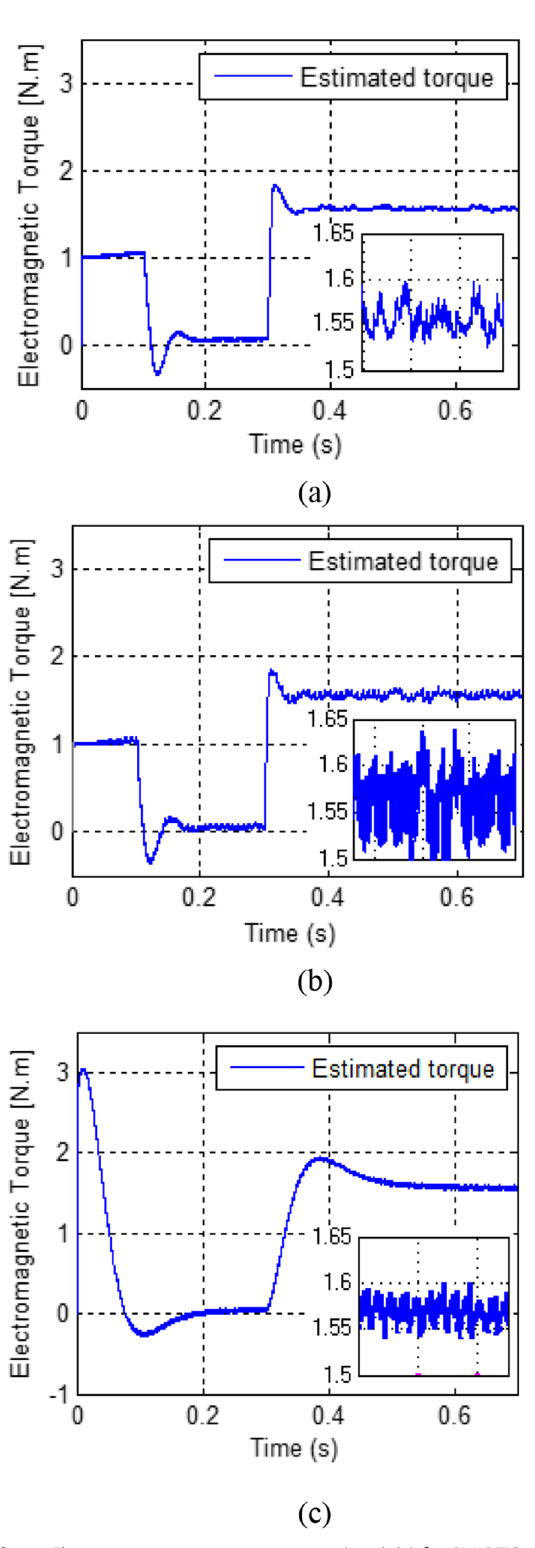
Fig. 9 Stator currents (A) ( a ) for SM-DTC with a three-level NPC inverter, ( b ) for SM-DTC with a two-level inverter and ( c ) for PI-DTC with a three-level NPC